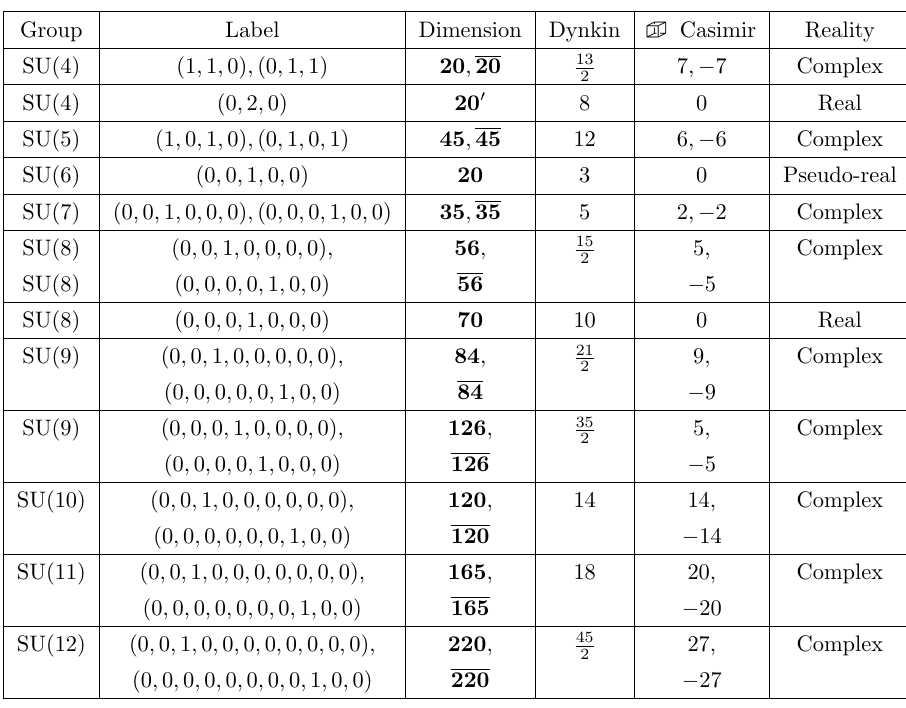
Table 8 . Various group theory data for SU( N ) representations associated with tensors with more than two indices. Here the group entry stands for the group in question, and the label entry stands for the standard Dynkin label of the representation. The remaining entries list the dimen- sion, Dynkin index (AKA quadratic Casimir), cubic Casimir and the reality properties of each